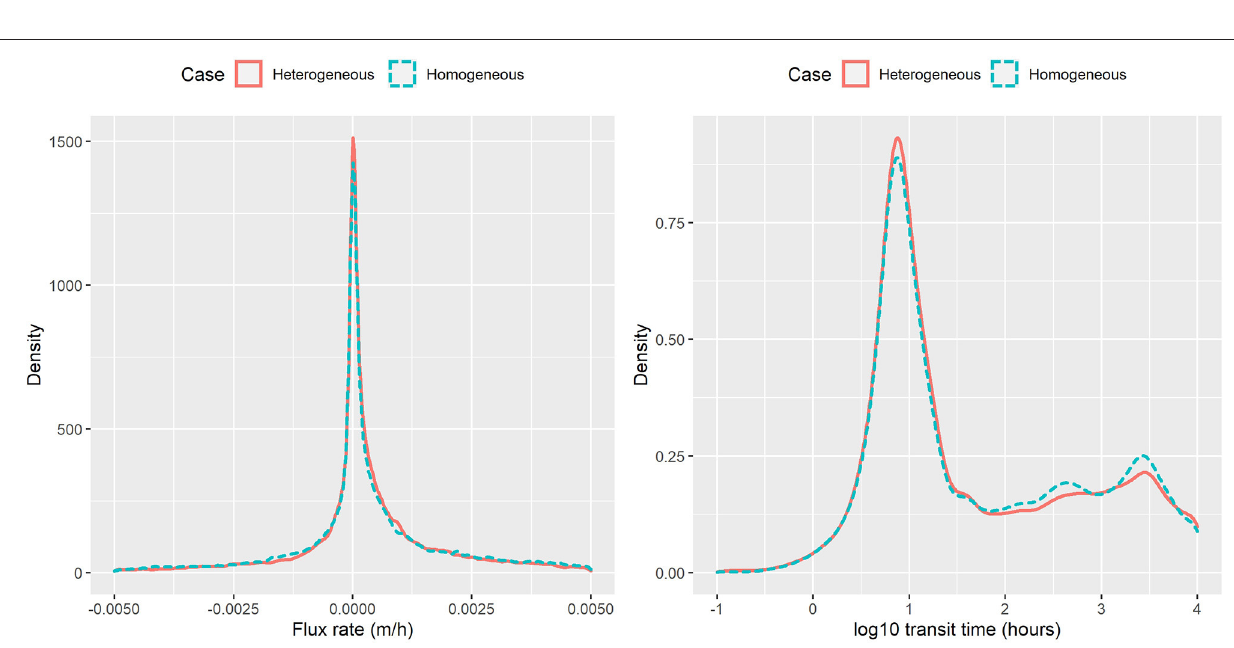
Frontiers in Artificial Intelligence |